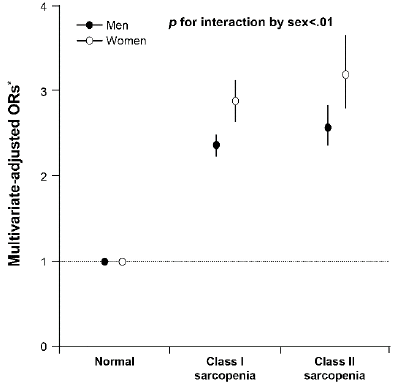
Figure 4. Multivariate-adjusted ORs (95% CI) for presence of metabolic syndrome according to sarcopenia status in men and women. p value for interaction by sex between metabolic syndrome and sarcopenia status is indicated. Adjusted ORs were estimated from a multivariate logistic re- gression model with presence of metabolic syndrome as the outcome. * Multivariate model 2 was adjusted for age, height, serum creatinine, ALT, hs-CRP, total vitamin D, current smoker, heavy drinking, and regular physical activity. ALT = alanine aminotransferase; CI = confidence interval; hs-CRP = high-sensitivity C-reactive protein; ORs = odds